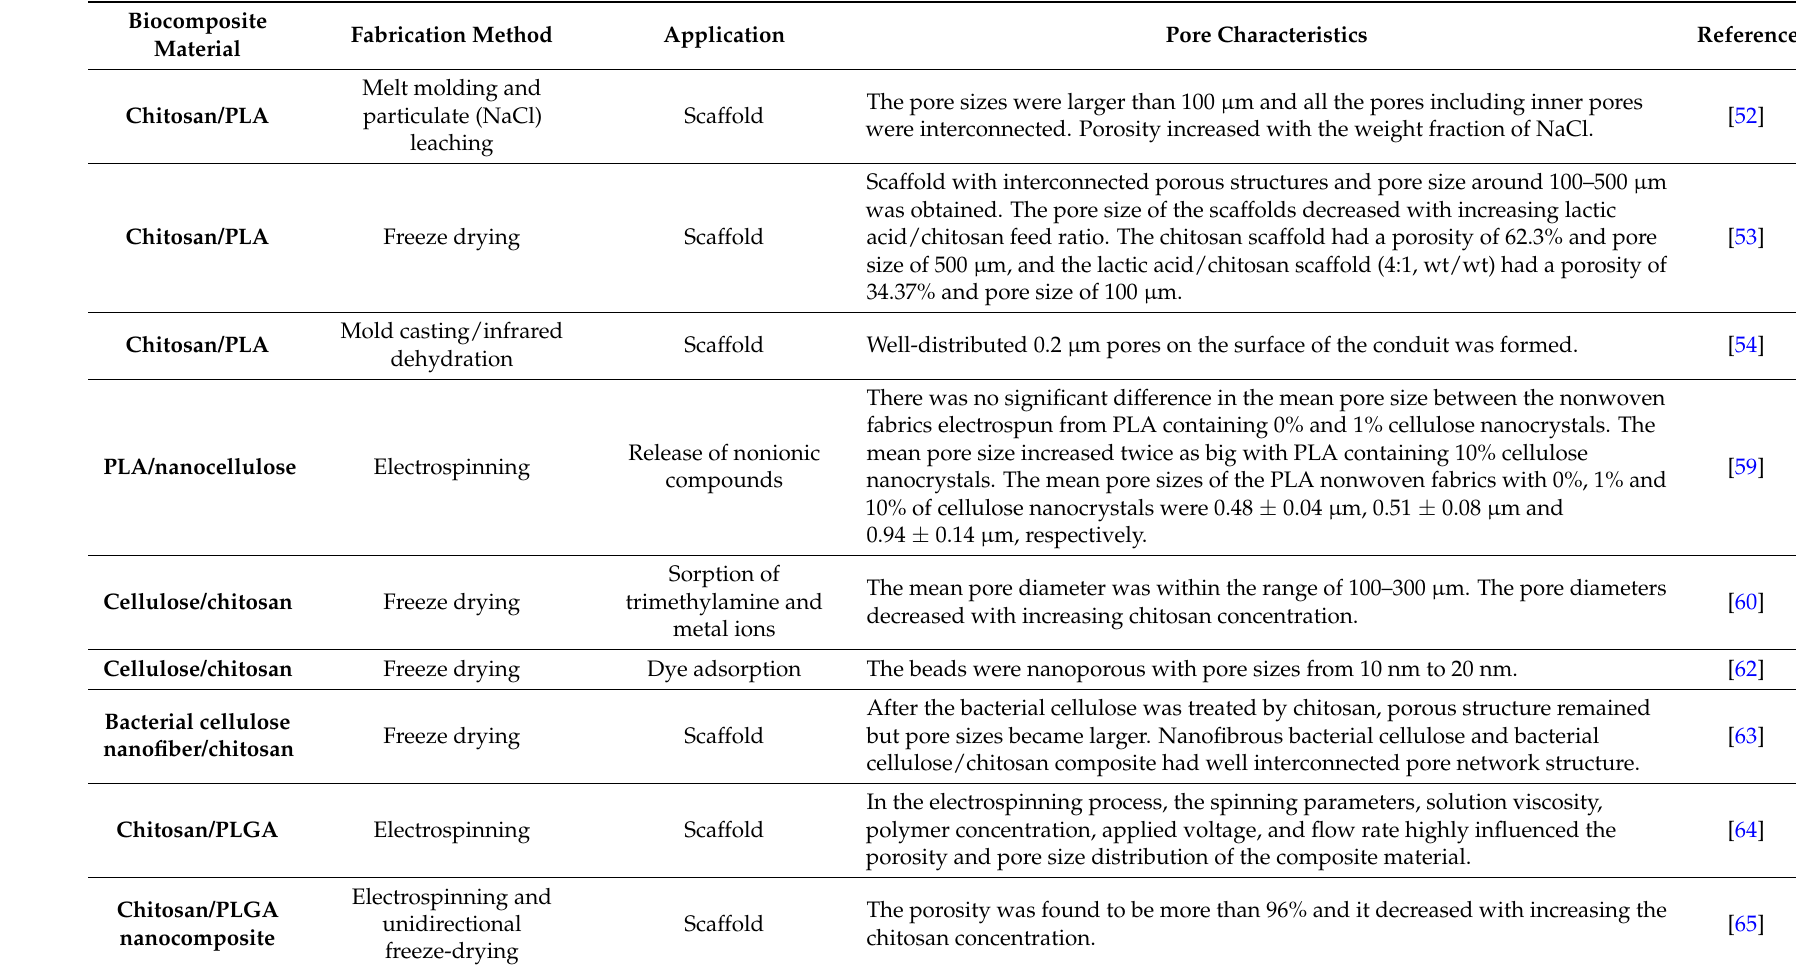
Table 2. An overview of pore characteristics of biocomposite materials fabricated with different